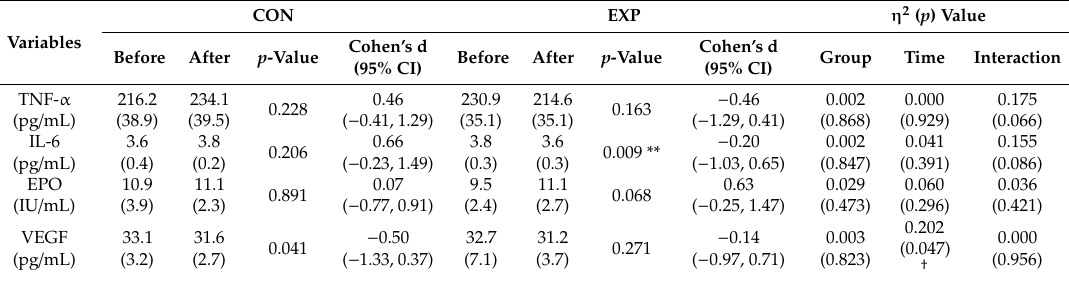
Table 5. Changes in cardiovascular risk factors before and after 12-week